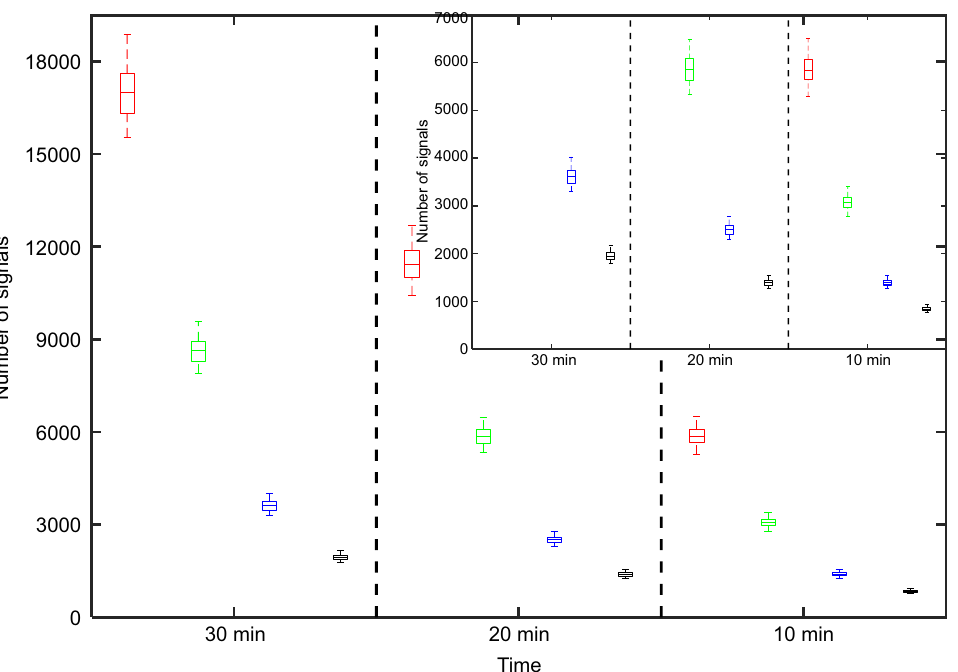
Fig. 2 Boxplot of the number of available signal rays for each scheme (red, green, blue, and blank represent the sampling rate of 30 s, 60 s, 150 s and 300 s, respectively)